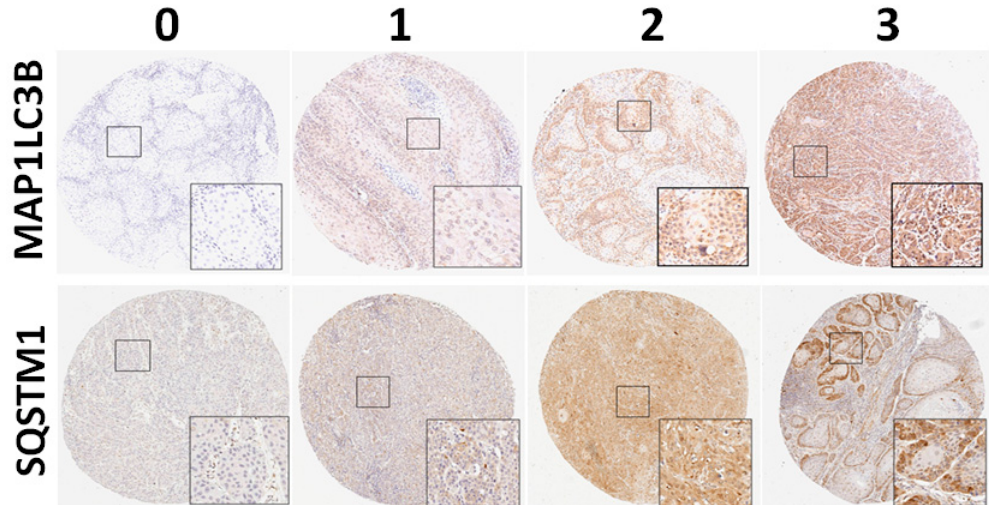
Figure 1. Protein levels of MAP1LC3B puncta and SQSTM1 in OSCC. The MAP1LC3B puncta and cytoplasmic SQSTM1 were stained by immunohistochemistry and categorized into four different levels as follows: 0 = negative staining; 1 = weak; 2 = moderate; 3 = strong.